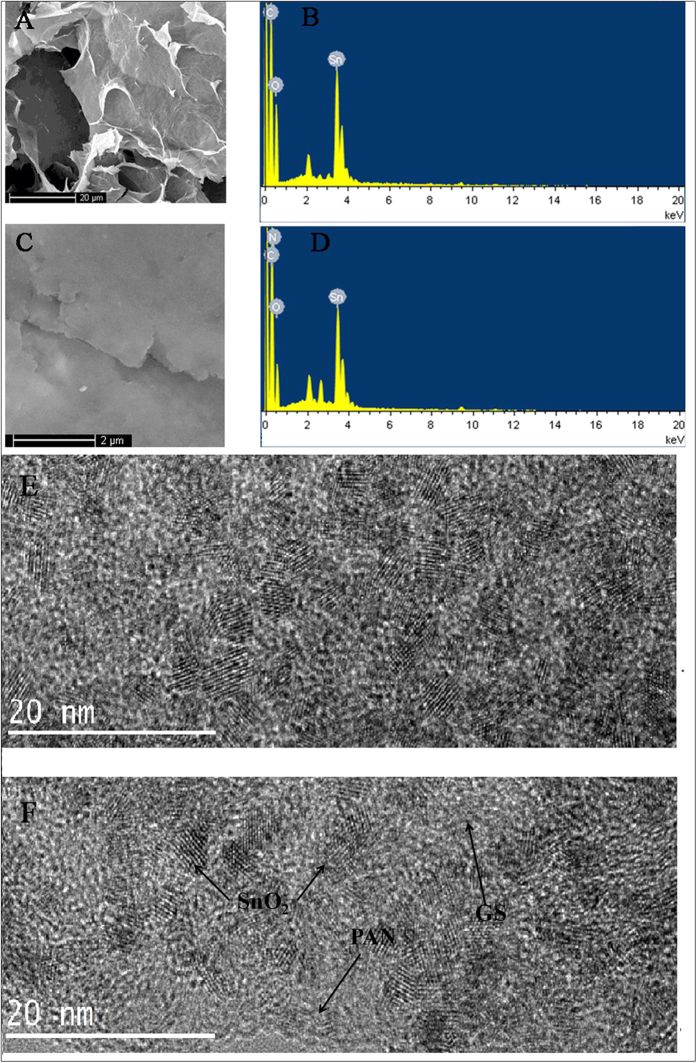
(A) SEM image of GS-SnO2; (B) EDS spectrum of GS-SnO2; (C) SEM image of GS-SnO2-PAN; (D) EDS spectrum of GS-SnO2-PAN; (E) HR-TEM image of GS-SnO2; (F) HR-TEM image of GS-SnO2-PAN.